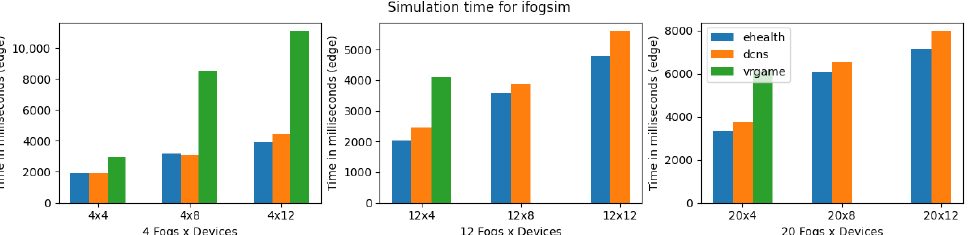
Figure 10. Execution time for